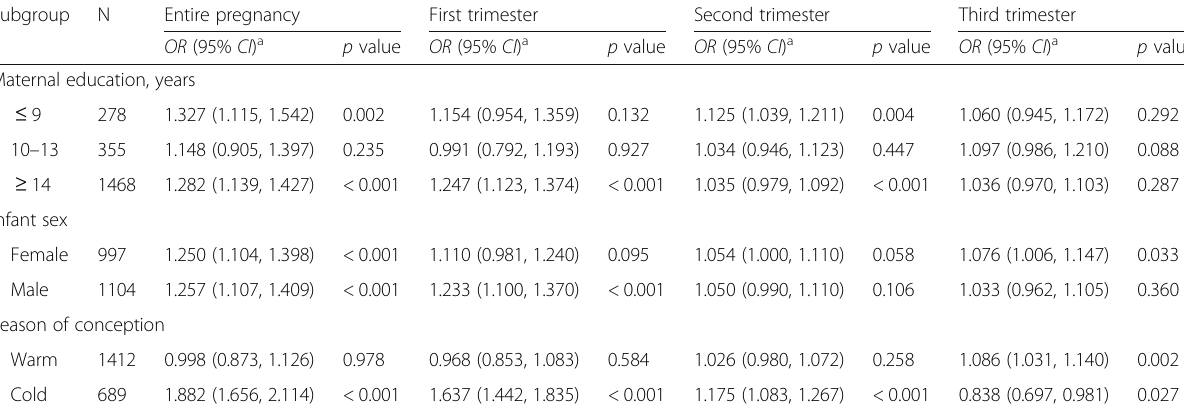
Table 4 Adjusted odd ratios of preterm births for each 10 μ g/m 3 increment in PM 2.5 exposure during the entire pregnancy and trimesters in each